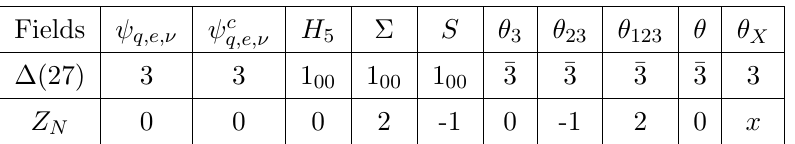
Table 1 . Fields and their family symmetry assignments. The (cid:12)eld (cid:18) X only plays a role in the vac- uum alignment. Hence the only requirement of its Z N charge is that it be assigned so that the (cid:12)eld does not contribute signi(cid:12)cantly to the fermionic mass matrices | we have therefore left it generic. assignments of our model. The (cid:12)eld S is Z charged and indirectly a(cid:11)ects the Majorana N terms such that the UTZ is preserved (see section 3). The (cid:12)eld (cid:6) is associated with the breaking of the underlying GUT with a vev / B (cid:0) L + (cid:20)T R . It implements the 3